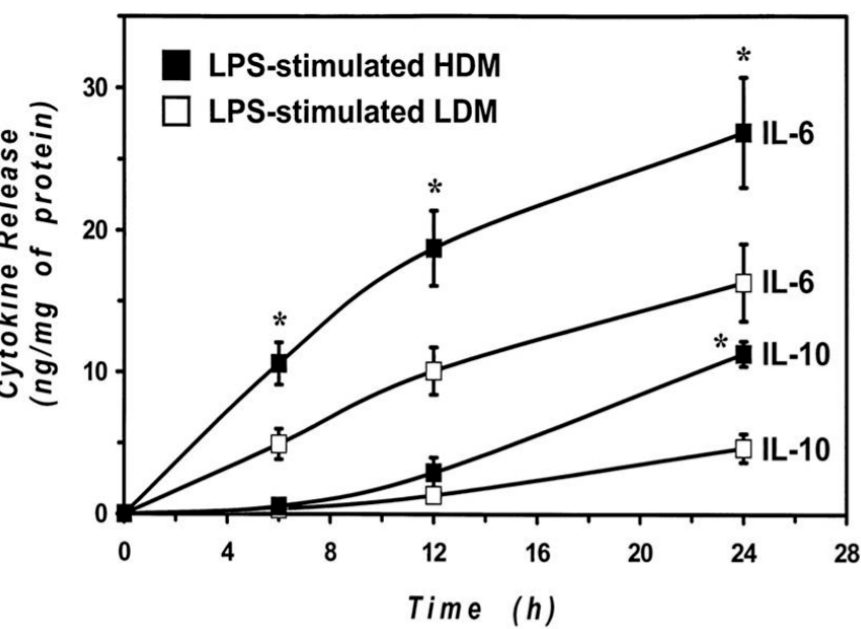
Figure 6. Kinetics of IL-6 and IL-10 release induced by LPS from LDMs and HDMs. HDMs and LDMs were incubated with LPS (1 µg/mL) for different times (6–24 h). Supernatants were collected and centrifuged (1000 g, 4 °C, 5 min). IL-6 and IL-10 release was determined by ELISA. Values are expressed as ng of cytokine/mg of protein. Data are the mean ± SEM of four experiments. * p < 0.05 vs.